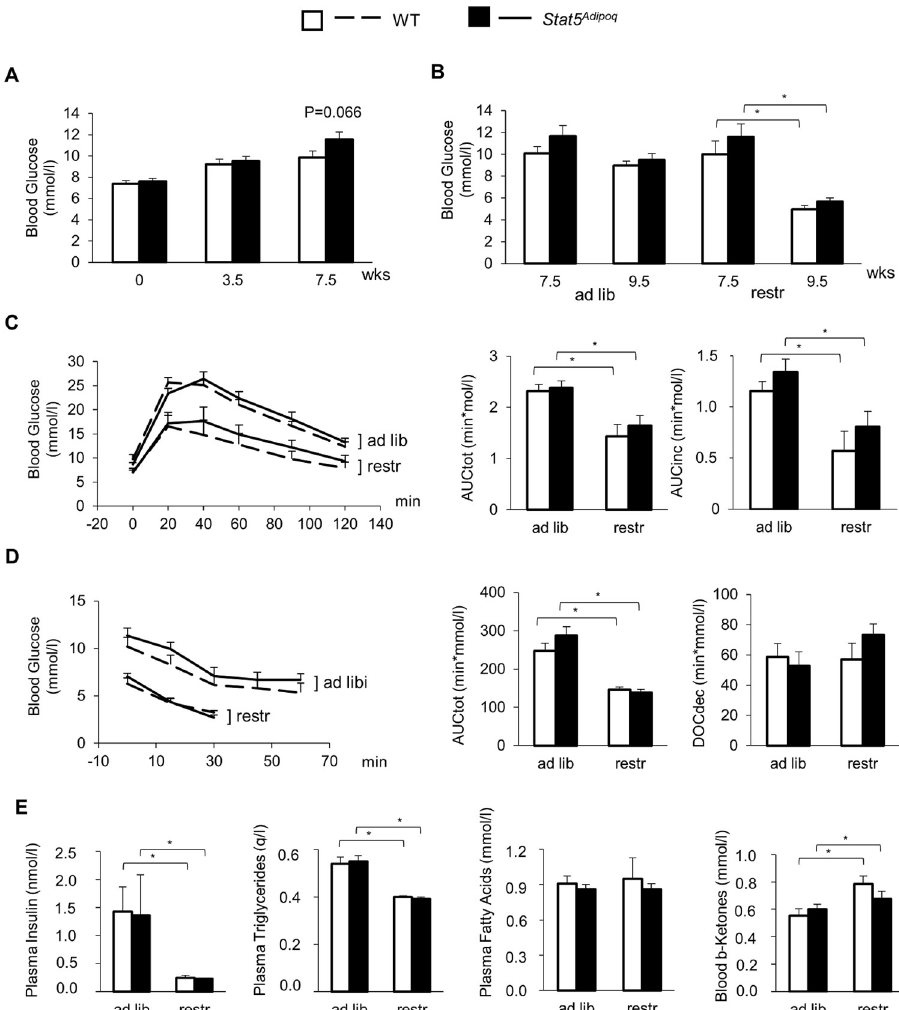
Fig 3. Effects of STAT5 adipocyte deficiency on glucose and lipid metabolism. Basal blood glucose of male mice lacking STAT5 in their adipocytes (Stat5 Adipoq ; n = 20) and their wild type controls (WT; n = 16) fed high-fat diet (HFD) ad libitum for 7.5 weeks (A). Thereafter, mice of both genotypes were divided into two groups each, one fed HFD ad libitum (ad lib), one fed HFD restrictedly (1 g/d) (restr). After 2–3 weeks, basal blood glucose (B), glucose tolerance test (C), insulin tolerance test (AUC and DOC refer to 0–30 min) (D), and circulating insulin, triglycerides, free fatty acids, and β -ketones (E) were assessed. Means ± SEM; n = 7–12 per group; AUCtot, total area under the curve; AUCinc, incremental area under the curve; DOCdec, decremental area over the curve; � p < 0.05 ad lib vs restr; no significant differences for WT vs Stat5 Adipoq .